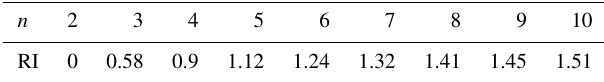
Table 2. Fundamental scale for pairwise comparisons (Saaty, 1987). Table 3. Random consistency index